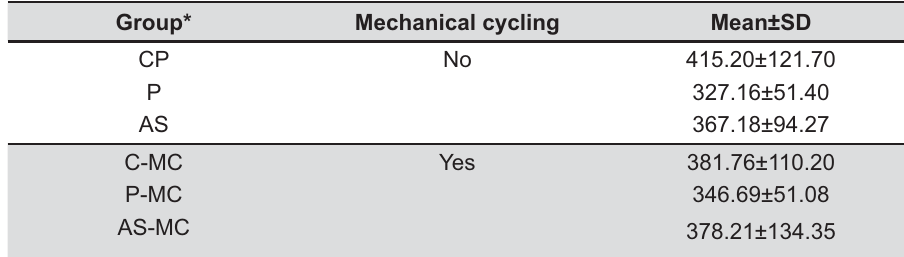
failure with adhesive and cohesive failures Table 3- Means ± standard deviation of the fracture load (N) Group*